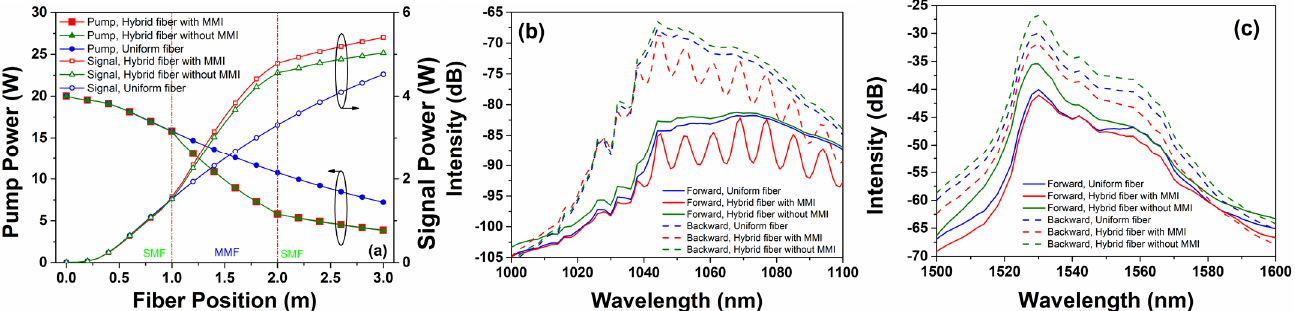
Figure 3. (a) Simulated pump and signal power evolution of amplifier with hybrid fiber and uniform fiber. (b) The simulation spectra at the 1-μm band. (c) The simulation spectra at the 1.5-μm band.